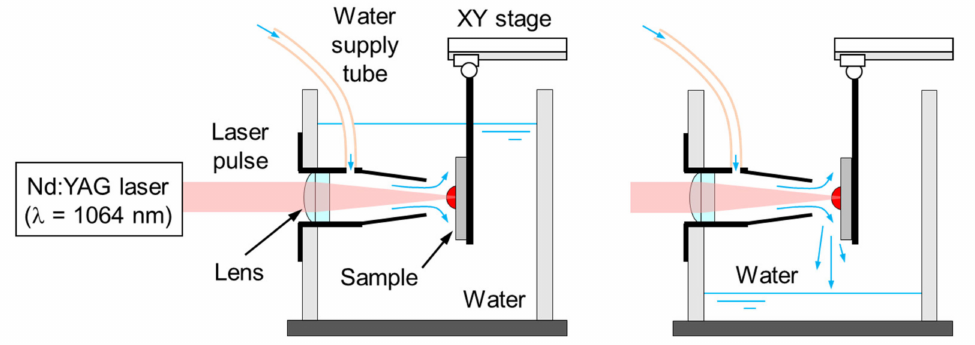
Figure 2. The LPwC setup for flat samples. Underwater mode ( left ) and water spray mode ( right ). During LPwC of round rod samples, each sample was placed on a rotating stage and simultaneously driven up or down by a linear stage in the direction of the sample axis; thus, the sample was treated in a spiral manner. A photograph of the setup is shown in Figure 3; we employed the underwater mode to reduce splashing and peening noise.